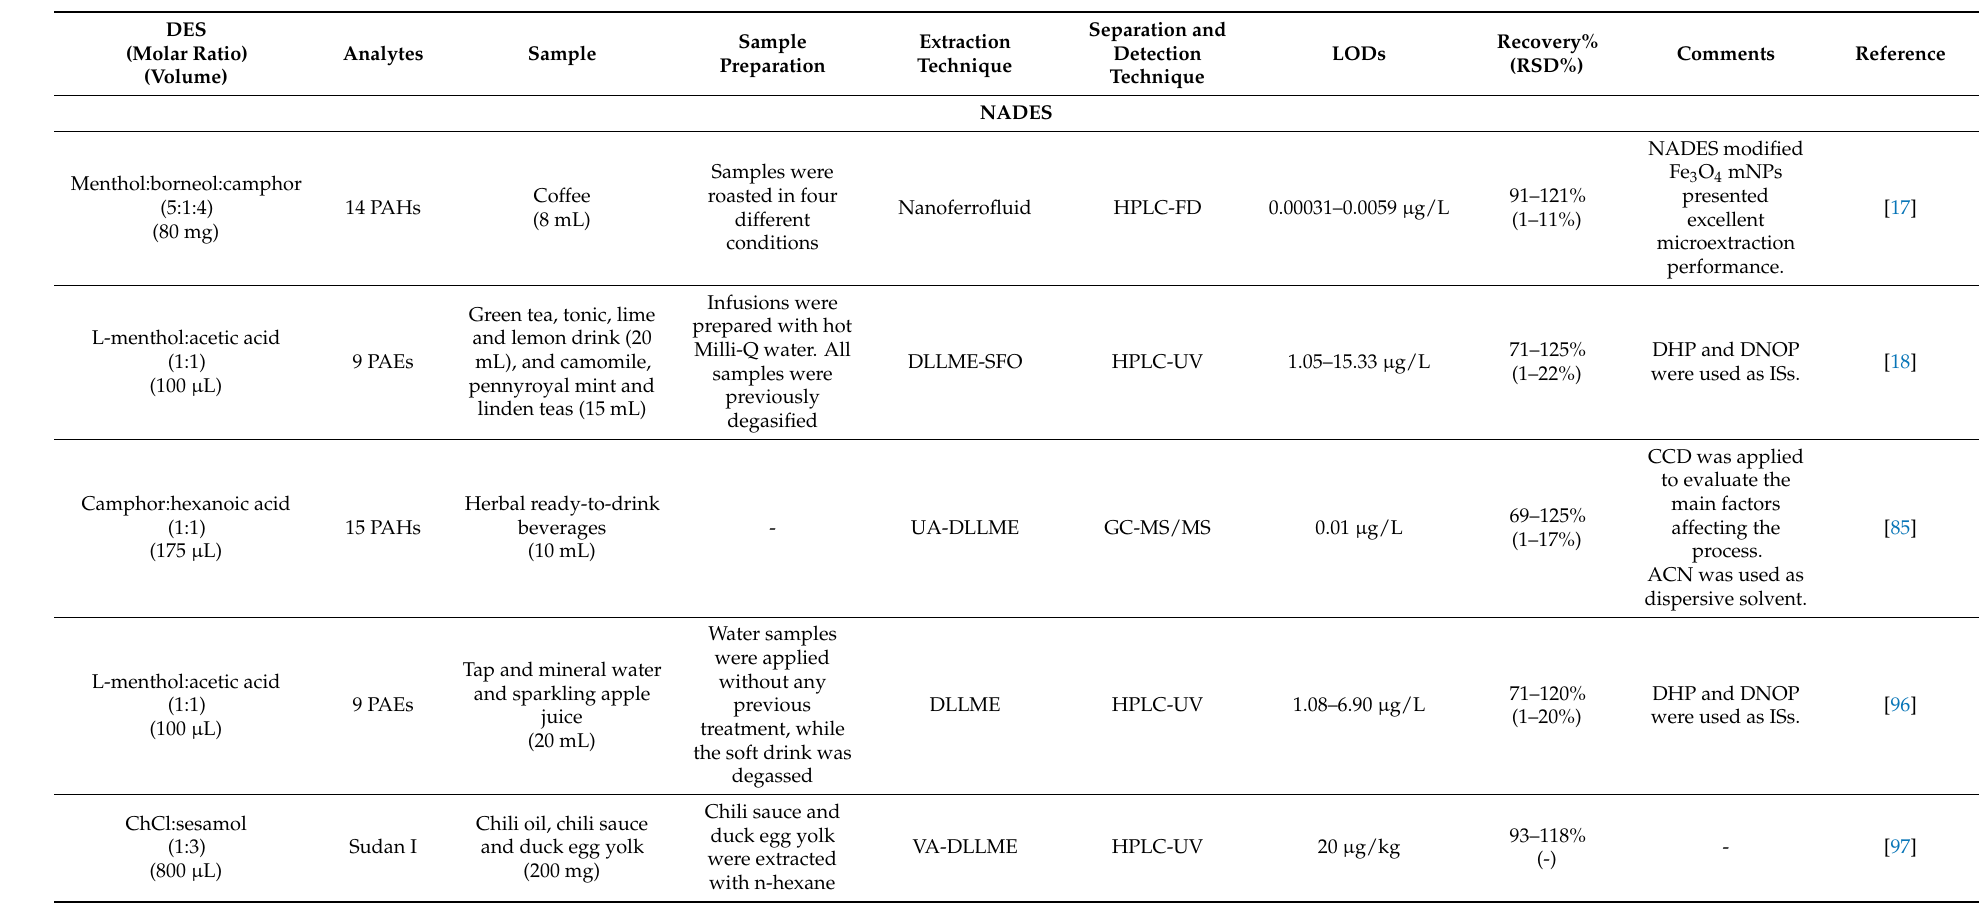
Table 2. Application of hydrophobic or quasi-hydrophobic DESs in sample preparation procedures for food